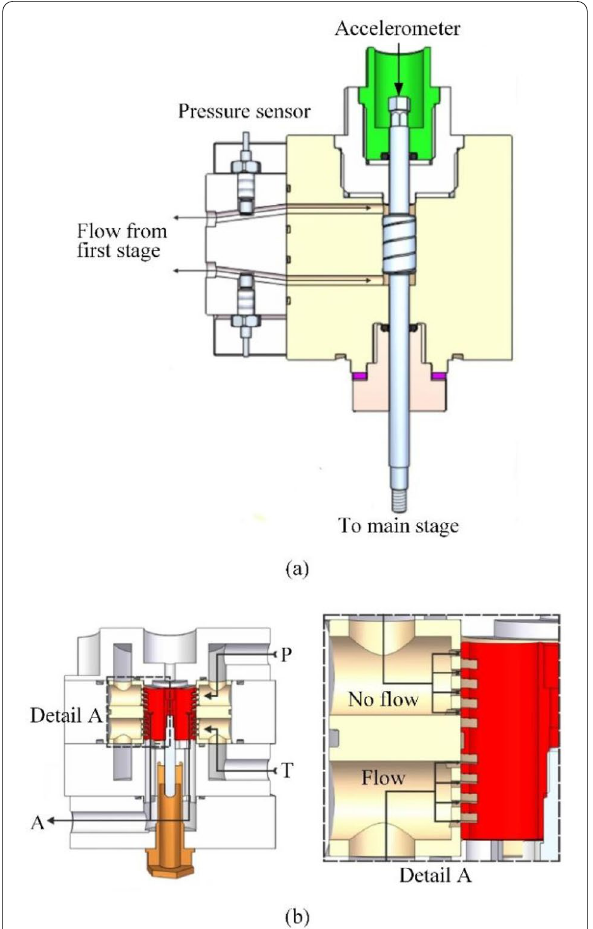
Figure 13 Three-stage valve provided by Johnston et al.: a actuation module, b main stage